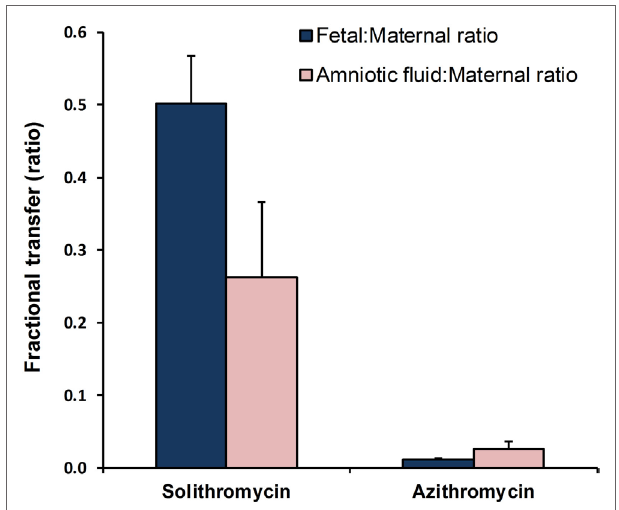
FiGURe 2 | Comparisons of maternal-to-fetal and maternal-to- amniotic transfer efficiency of solithromycin vs. azithromycin in the pregnant sheep model (10 and 5 mg/kg, respectively) . Data are mean ± SD; taken from Refs. (55, 82), respectively.